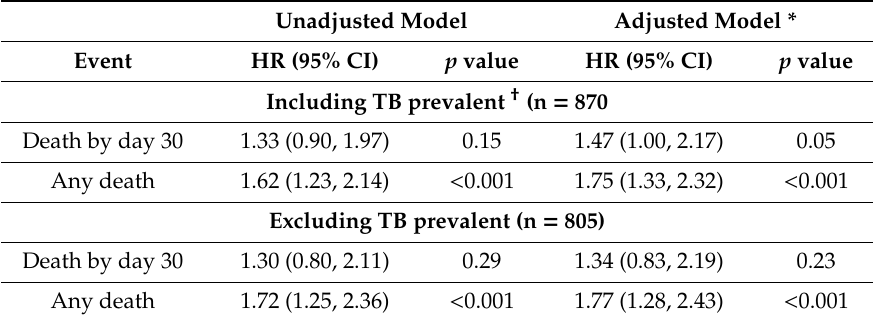
Table 3. Mortality risk of TB co-infection in cryptococcal meningitis in time-adjusted models compared to no TB